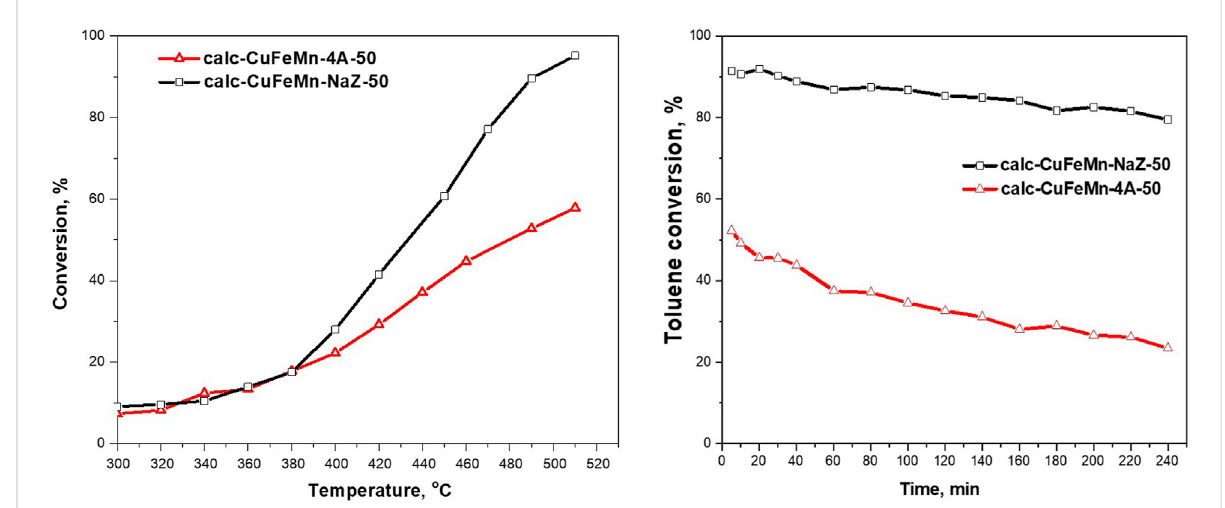
FIGURE 8 Catalyticactivityofthermallytreatedwastezeolitesasafunctionoftemperature(left)andtolueneconversionvstimeonstreamoftwotypesof zeolite in catalytic reaction of total toluene oxidation